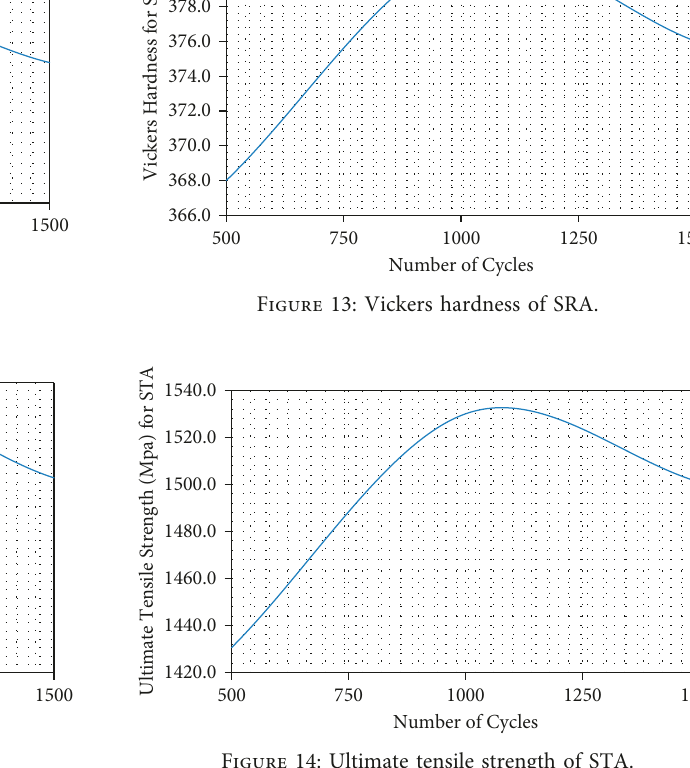
Figure 11: Ultimate tensile strength of SRA.